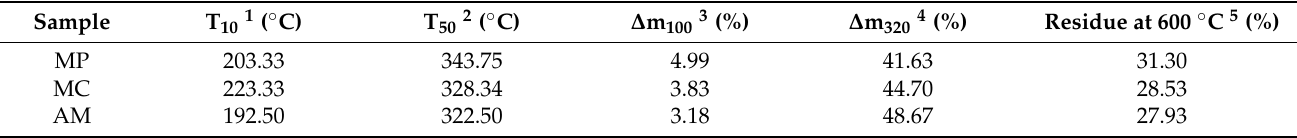
Table 2. Thermal stability of fillers determined by